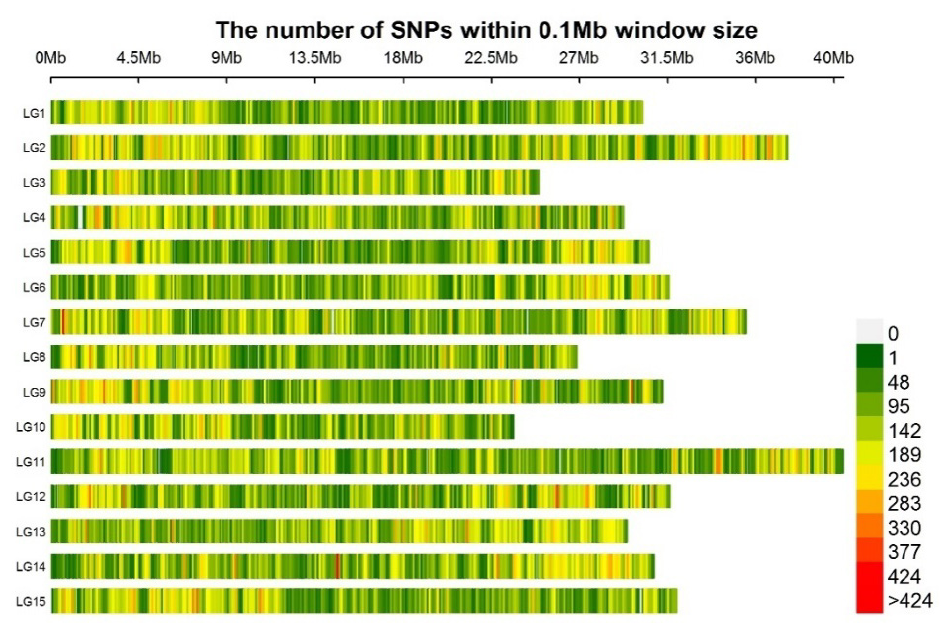
Figure 1. The distribution of SNPs in 15 LGs of sweet potato.